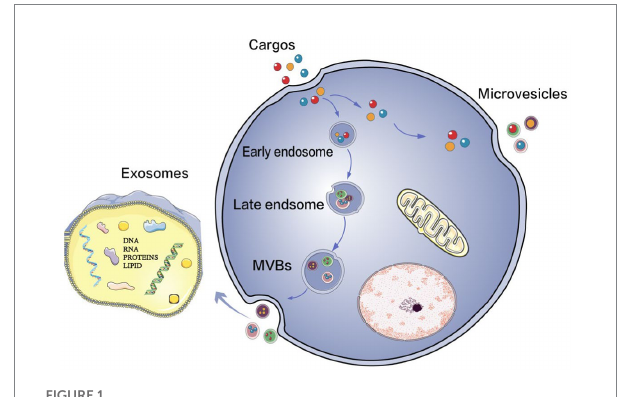
FIGURE 1 The biogenesis of EVs. Extracellular vesicles (EVs) mainly consist of two types: exosomes and microvesicles. Microvesicles bud off directly from the plasma membrane, and the production of exosomes involves the formation of multivesicular bodies (MVBs) upon transport and fusion with the plasma membrane.